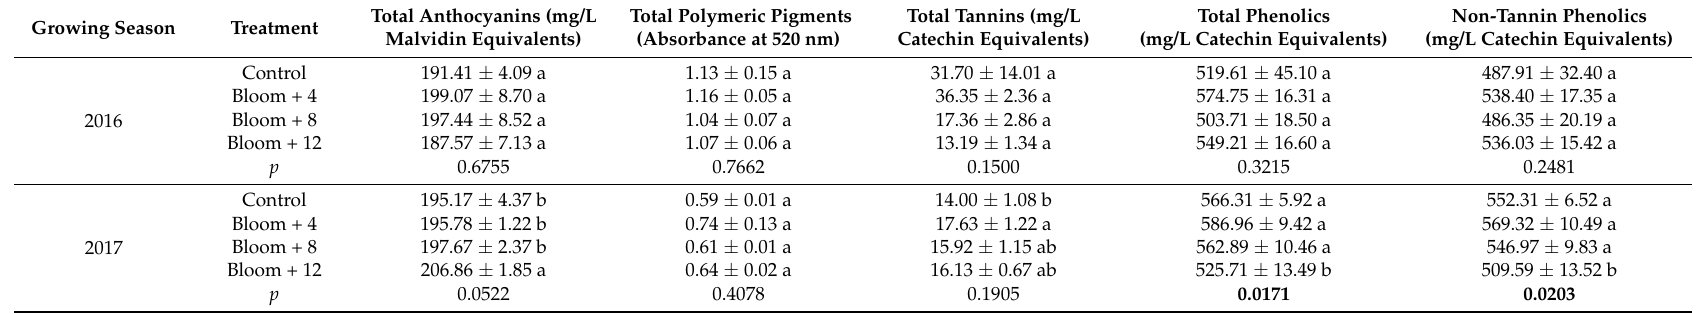
Table A6. Wine Phenolic profile post-malolactic fermentation by treatment and growing season. Treatment means followed by standard error of the mean. Different letters within a column and growing season indicate significant differences between treatment groups for Fisher’s LSD at p < 0.05. p values below 0.05 are shown in bold font.